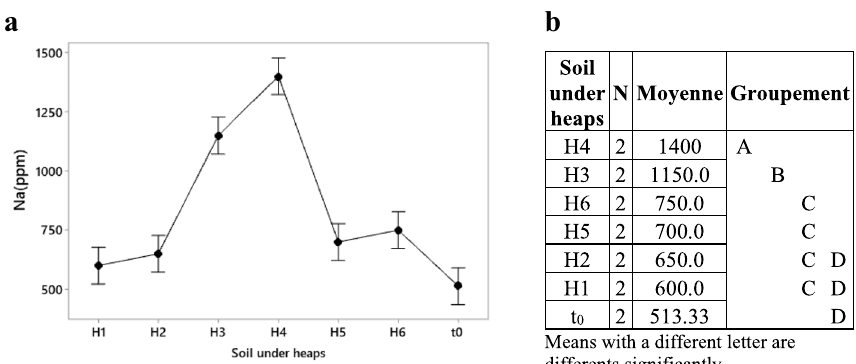
Fig. 8 Statistical tests related to Na content under the soil (p<0.05) : a confidence intervals related to Na means under the soil before ( t 0 ) and after composting (under H1 to H6) ( one-way ANOVA test ); b Tukey test